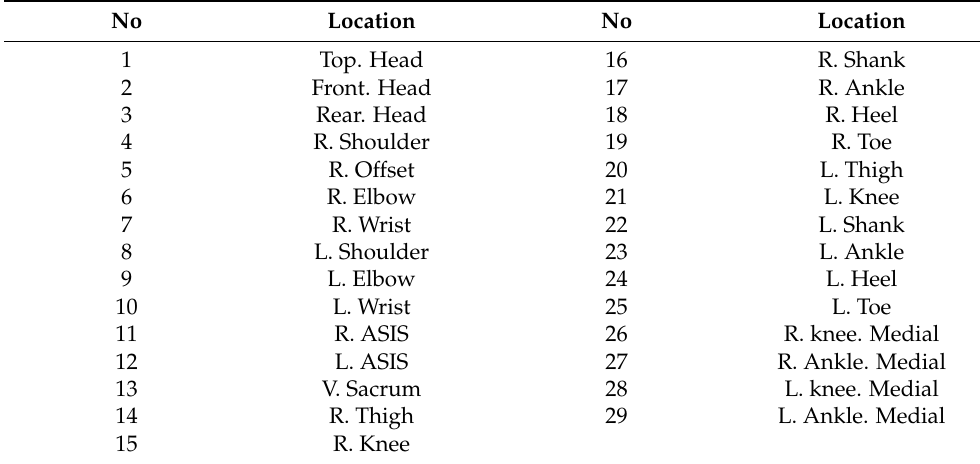
Table 1. The locations of retroreflective marker